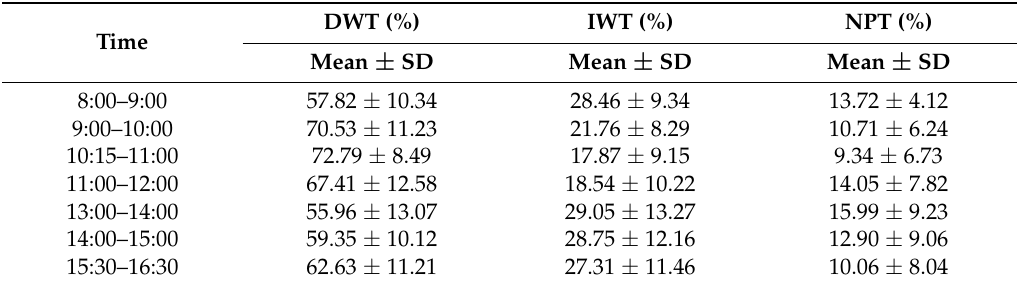
Table 4. Descriptive statistics of the CLP in DWT, IWT, and NPT.